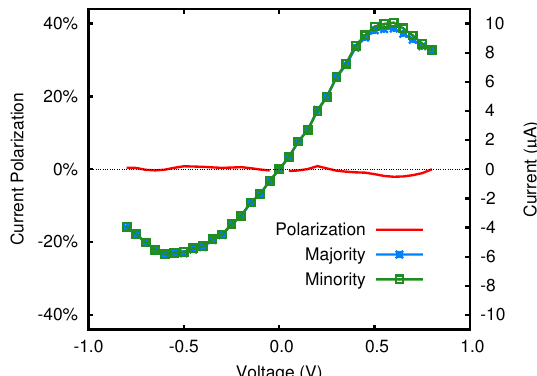
Figure 11. I ( V ) curve in the FeP nanojunction with B/N-doped